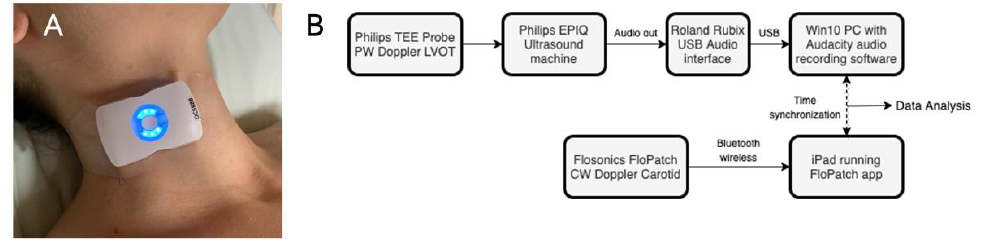
Figure 1. ( A ). The wireless, wearable Doppler ultrasound on a volunteer. ( B ). The experimental set-up with the novel, wearable biosensor (FloPatch TM ). PW is pulse wave; LVOT is left ventricular outflow tract; CW is continuous wave; app is application; USB is universal serial bus; Win10PC is Windows 10 personal computer.